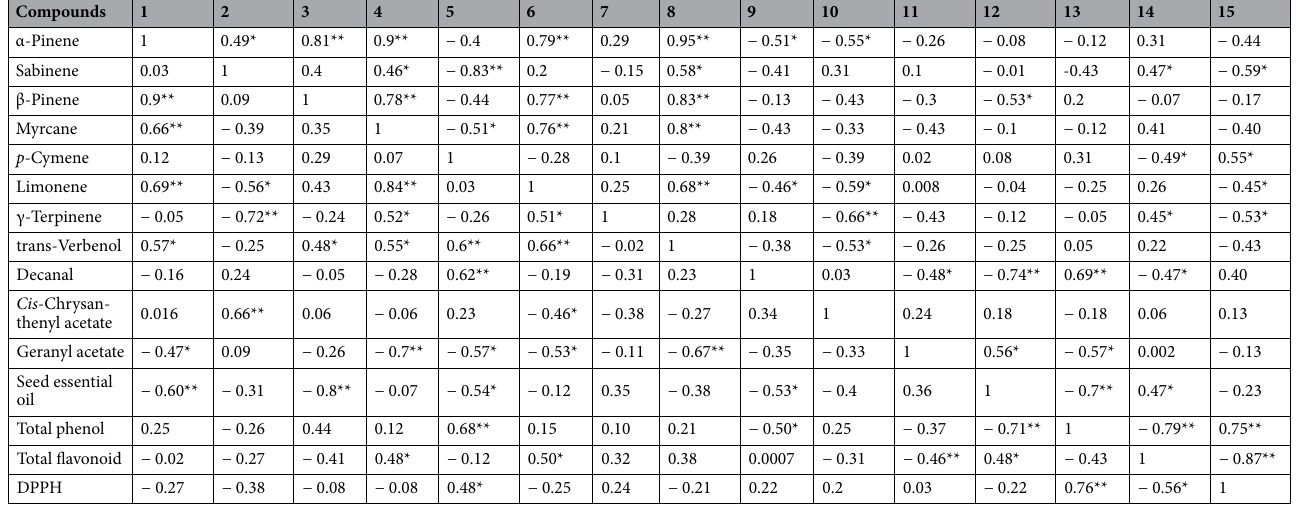
Table 4. Pearson correlation coefficients between major essential oil compounds of fruit essential oil, total phenol, total flavnoid and DPPH of eight Moshgak population in control (lower triangle) and moderate